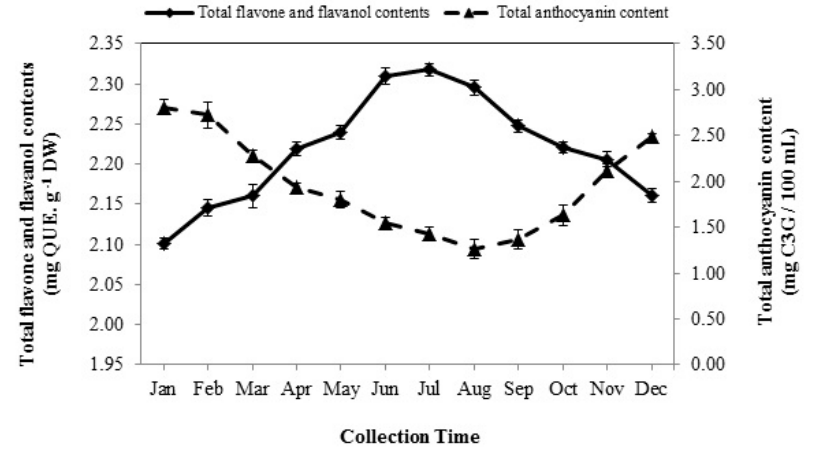
Figure 3. The seasonal variation of total flavone and flavanol, and anthocyanin content of Arabian lilac. Values are the mean ± SD of three replications ( n = 3). QUE: quercetin equivalents.